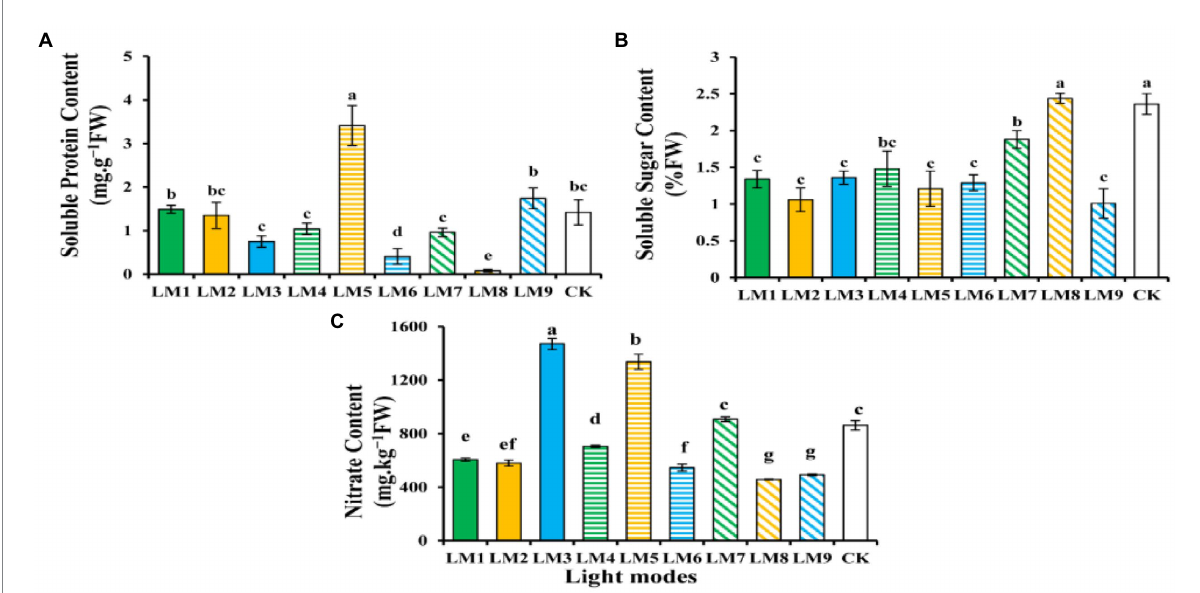
FIGURE 5 The influence of modes of LED light on biochemical characteristics in strawberry plants: soluble protein content (A) , soluble sugar content (B) , and nitrate content (C) . Each column represents the means of three technical replicates ( n = 5); the same letter within the same series is not significantly different according to Duncan’s multiple range test ( p ≤